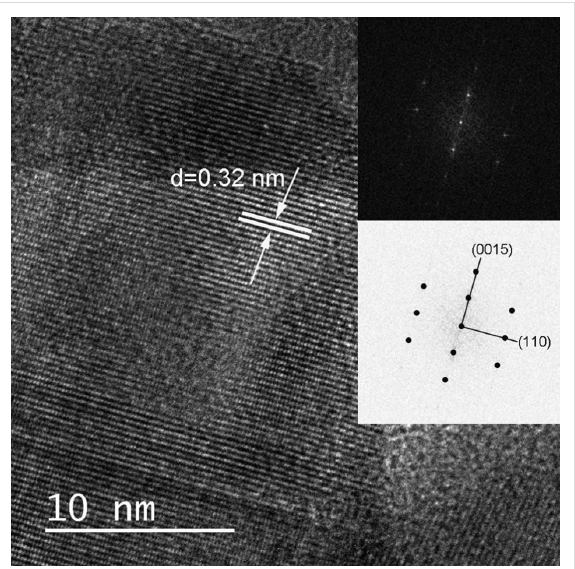
Figure 4: Absorbance of copper sulfide nanocrystals synthesized in an aqueous solution and in an organic solvent. A clear shift towards low energies is observed in the Cu x S samples synthesized in the range from 230 to 260